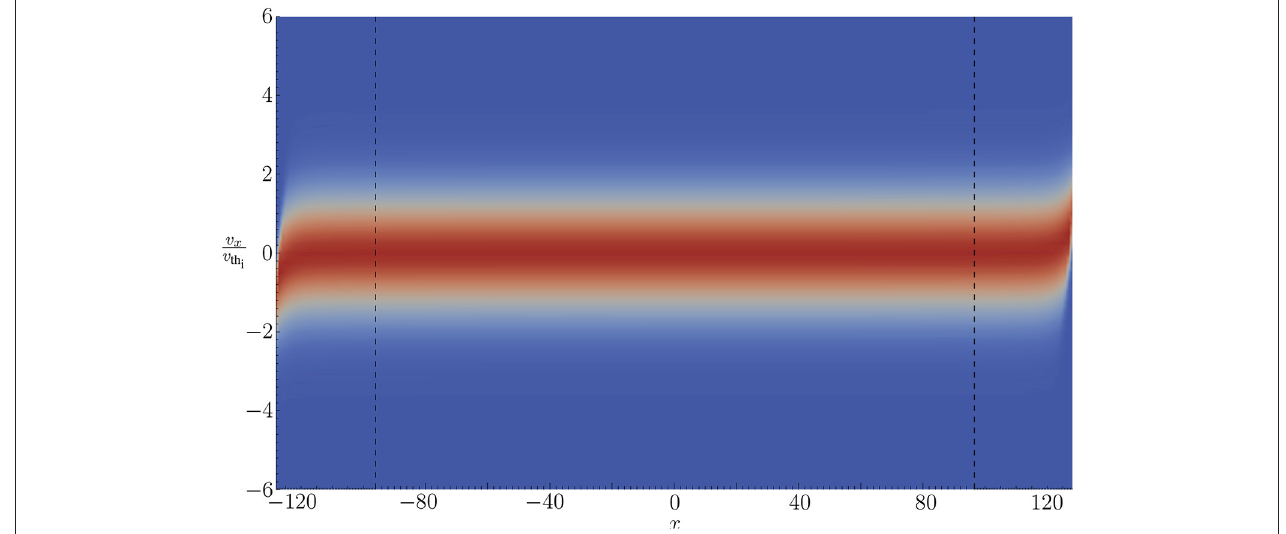
20 /ω p e solved using the domain-hybridized plasma model. The left and right subdomains =